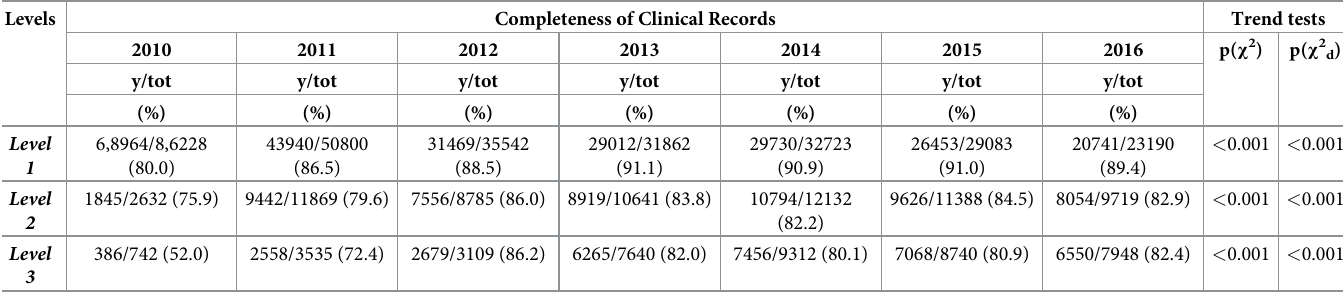
Table 3. Trend tests by levels.